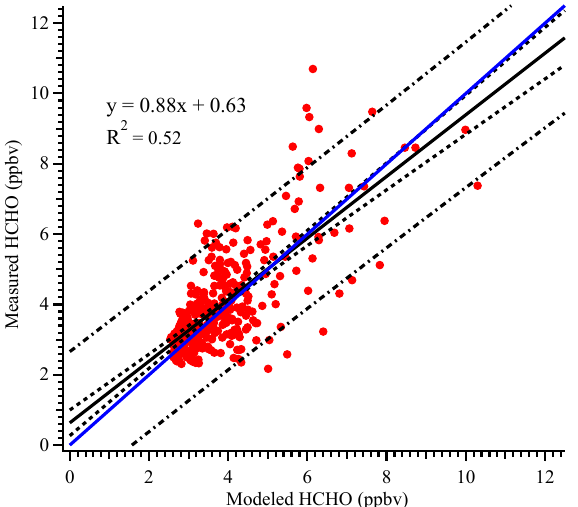
Figure 11. Linear correlation between the approximated and mea- sured HCHO concentrations. Both data sets are synchronized into 1h temporal resolutions. The blue trace represents the 1:1 guide- line. The black solid line is the linear fit based on orthogonal dis- tance regression. The dashed line and the dot-dashed line denote the 95% confidence interval band and the 95% prediction band,